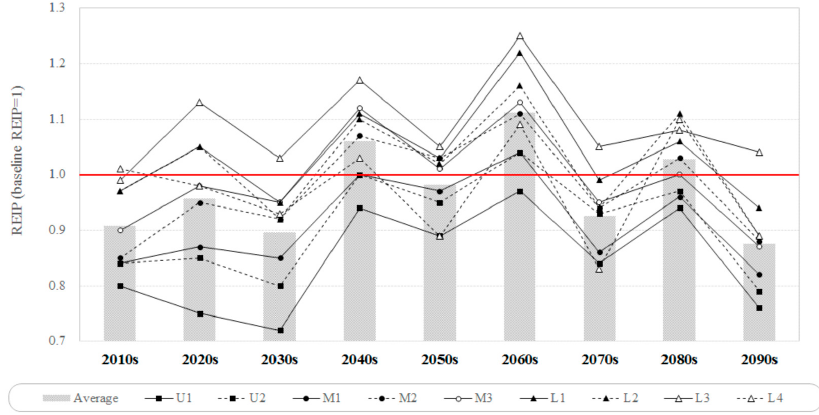
Figure 4. Temporal and regional changes in the REIP for climate change scenario RCP 4.5.